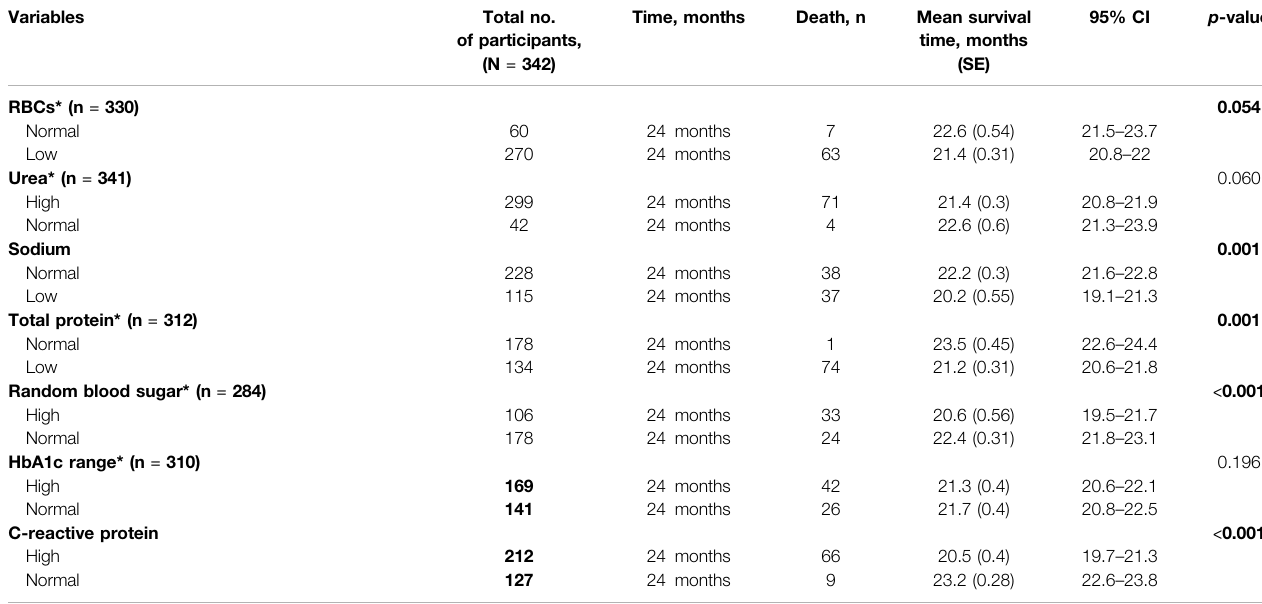
TABLE 2 | ( Continued ) Survival trends of study participants through Kaplan-Meier survival analysis. Variables